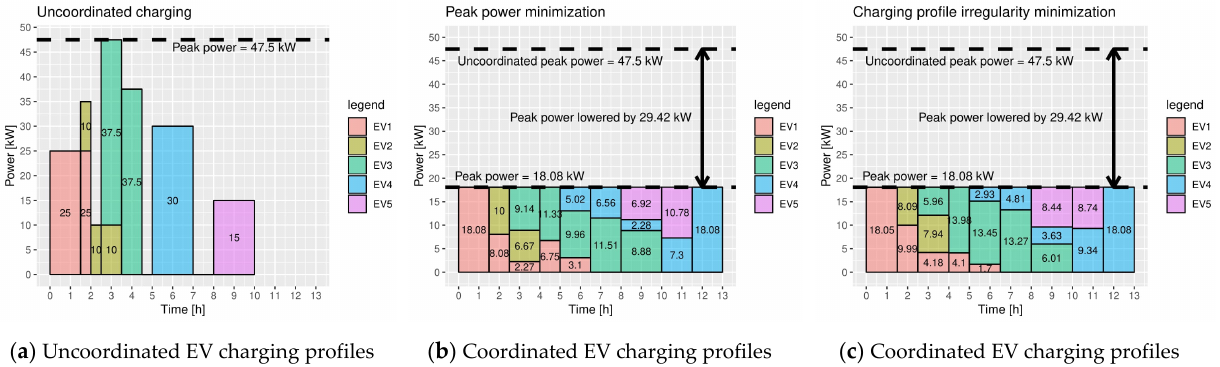
Figure 4. Illustration of a charging scenario: ( a ) no EV charging coordination, ( b , c ) with the utilization of the proposed algorithm.